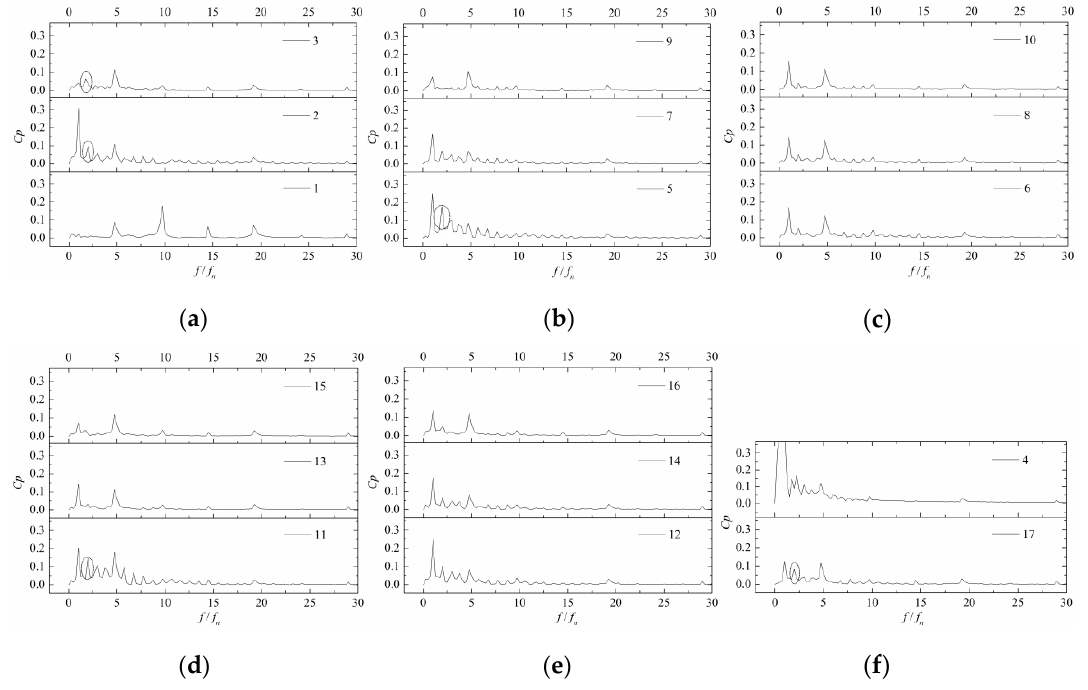
Figure 11. Pressure fluctuation coefficient with frequency. ( a ) Points 1, 2, 3; ( b )Points 5, 7, 9; ( c )Points 4, 6, 8; ( d )Points 11, 13, 15; ( e )Points 12, 14, 16; ( f )Points 4, 17.